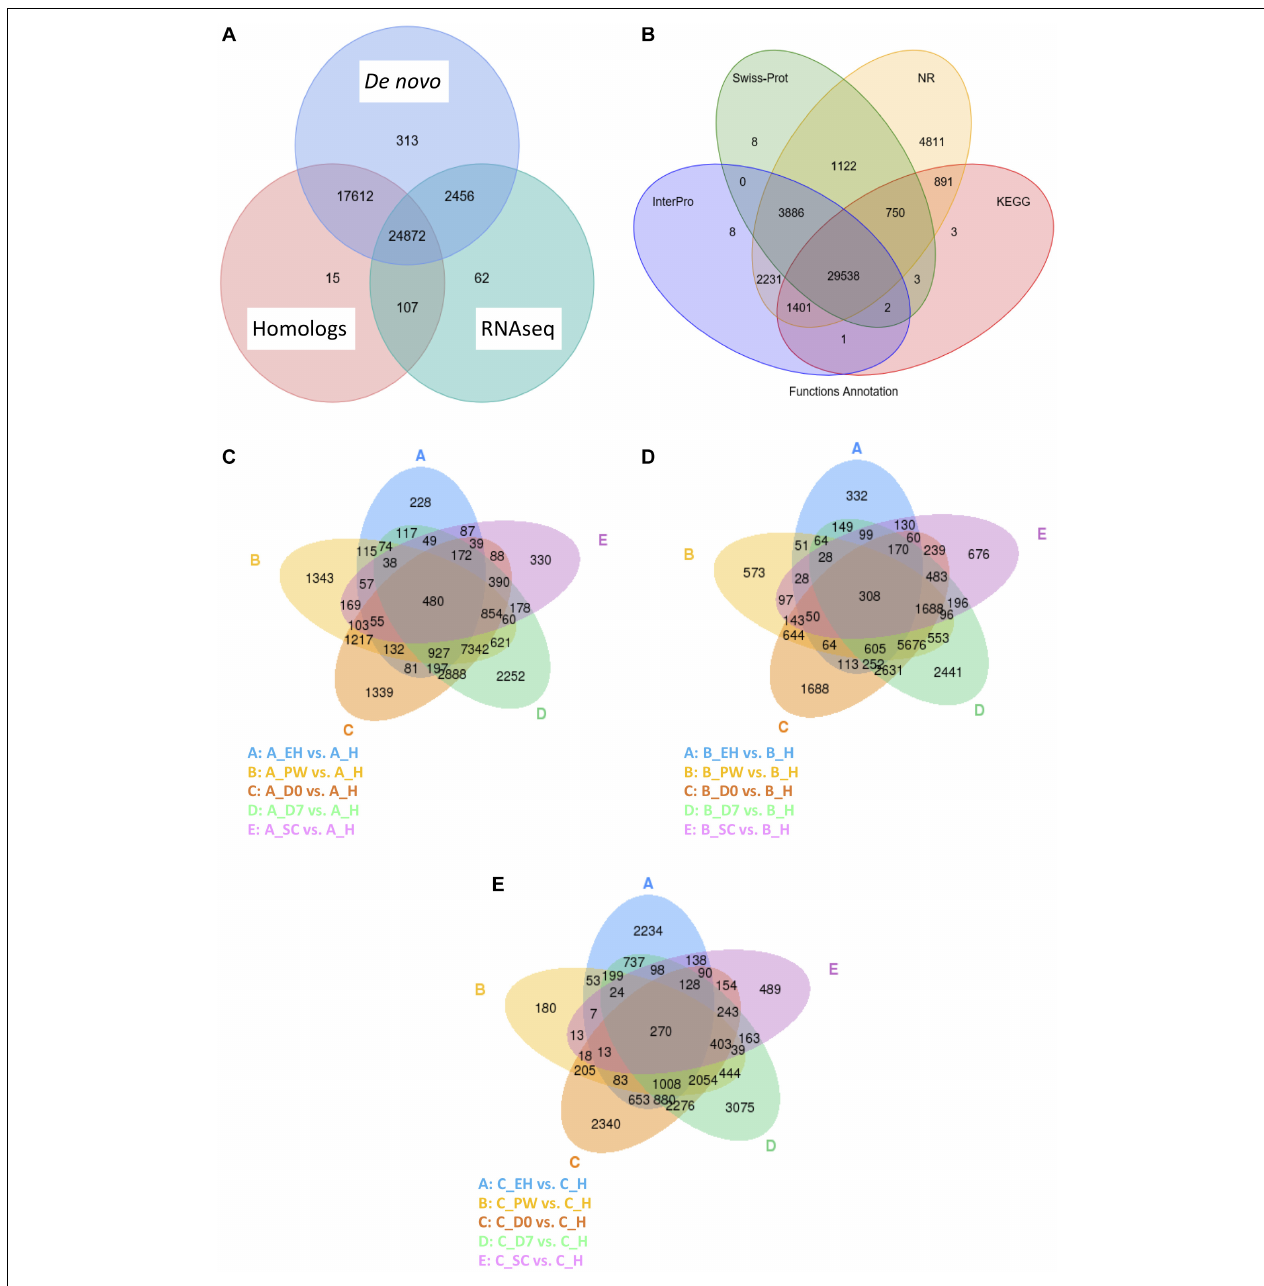
FIGURE 2 | Venn diagrams of the Eruca sativa reference genome annotation gene identification sources (A) and functional annotation databases used to assign putative gene identities (B) . Also shown are Venn diagrams of global differentially expressed genes (DEGs) at an early harvest ( EH ), second harvest ( SC ), pre-wash ( PW ), post-wash ( D0 ), and 7-day shelf life ( D7 ) time points relative to a first harvest ( H ) time point of three elite breeding lines: A (C) , B (D) , and C (E) . The numbers of DEGs identified under each condition are contained within the ellipses and their